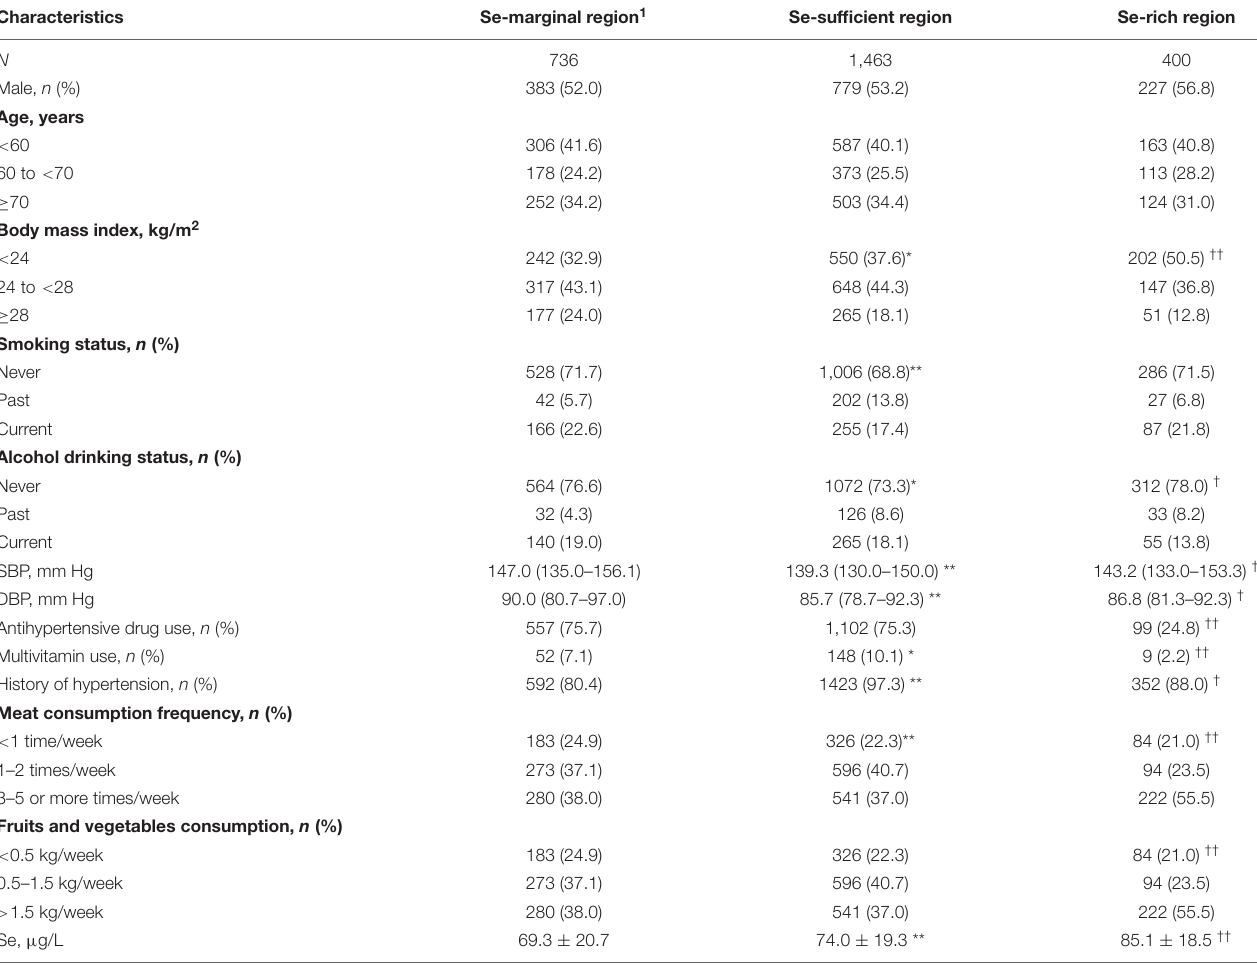
TABLE 1 | Baseline characteristics of the study participants stratified by